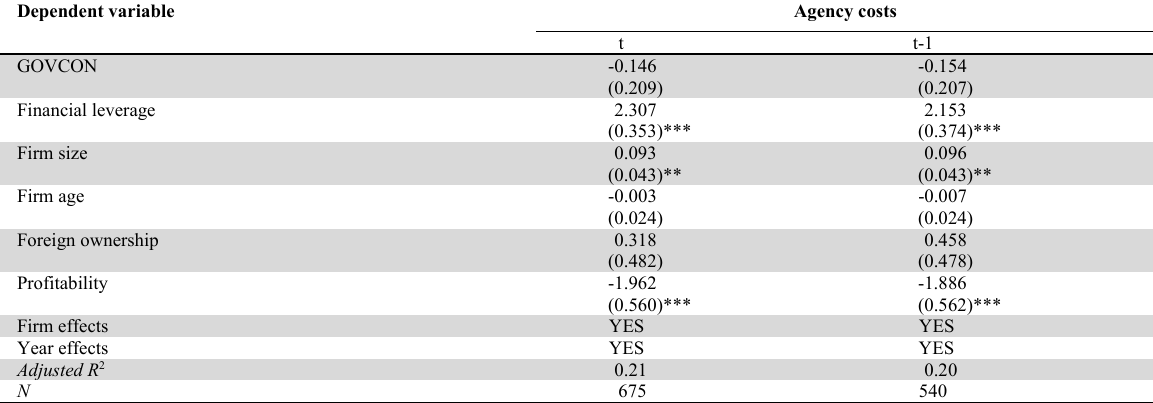
Robustness tests using one-year lagged values of independent variables (concentrated government ownership) Dependent